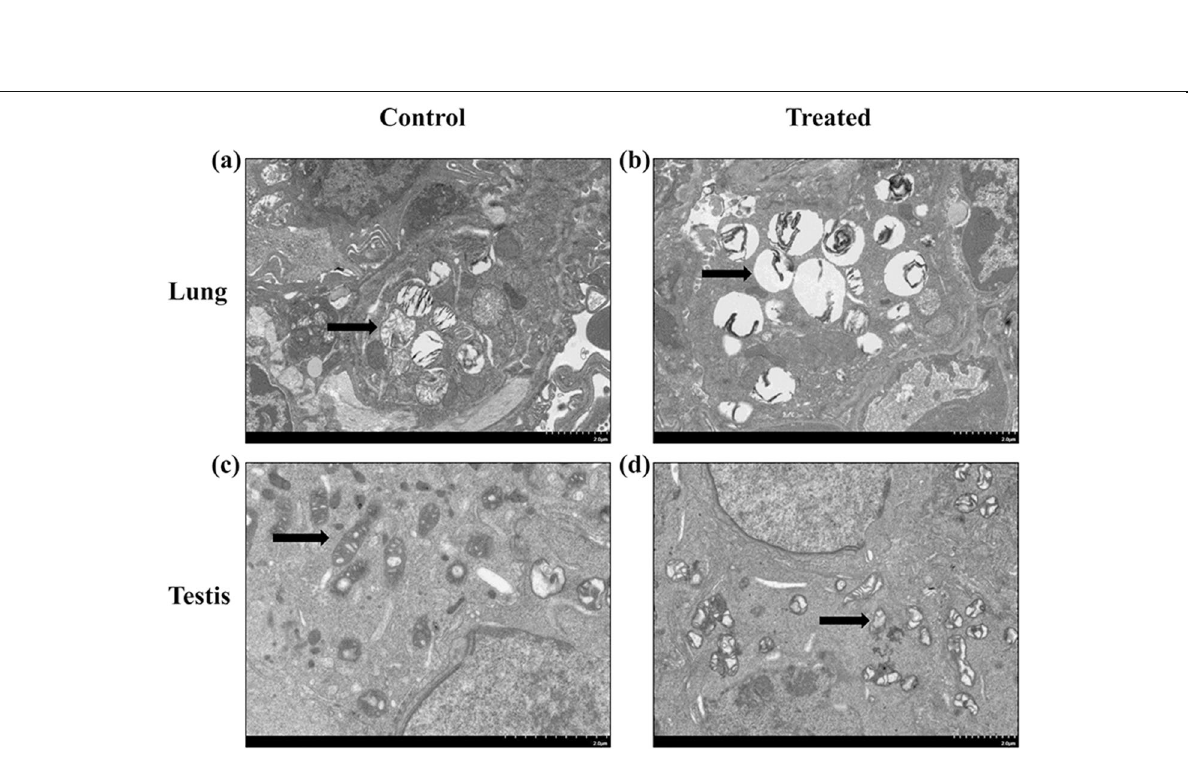
Fig. 2 TEM images of lung and testis tissues of rats exposed to SiO 2 NPs. a Morphology was assessed in lung tissues by SEM in controls. b Morphology was assessed in lung tissues by SEM in treated group. c Morphology was assessed in testis tissues by SEM in controls. d Morphology was assessed in testis tissues by SEM in treated group. Scale bars represent 2.0 μ